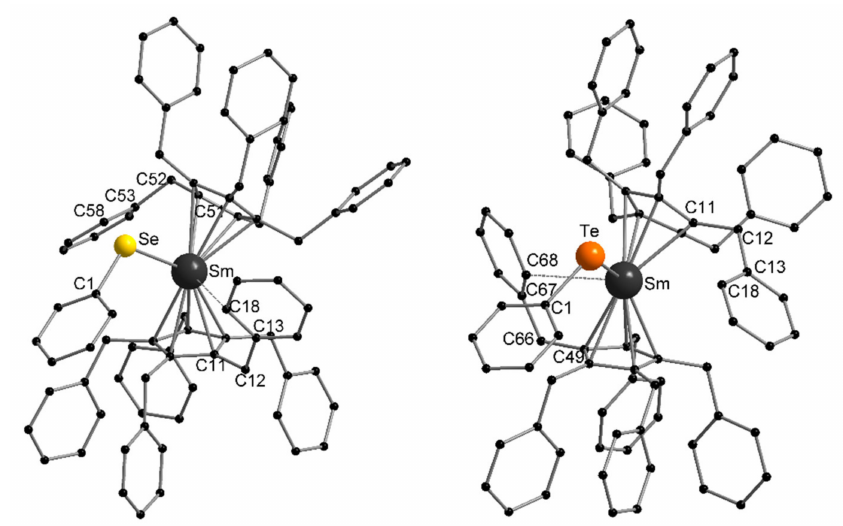
Figure 1. Molecular structures of 1 ( left ) and 2 ( right ) in the solid state. Hydrogen atoms and solvent molecules are omitted for clarity. Selected bond lengths [Å] and angles [ ◦ ]: 1 : Sm-Se 2.8679(8), Sm-Cp(Ctr) 2.4628(4), Sm-C18 3.077(7), Sm-C58 3. 712(8), Se-C1 1.929(8), Sm-Se-C1 111.7(2), C11-C12- C13 114.8(7), C51-C52-C53 118.6(7), Cp(Ctr)-Sm-Cp(Ctr) 139.67(2). 2 : Sm-Te 3.1186(2), Sm-Cp(Ctr) 2.4583(6), Sm-C68 3.007(3), Sm-C18 3.780(3), Te-C1 2.132(3), Sm-Te-C1 109.81(7), C49-C66-C67 114.5(2), C11-C12-C13 119.0(2), Cp(Ctr)-Sm-Cp(Ctr)